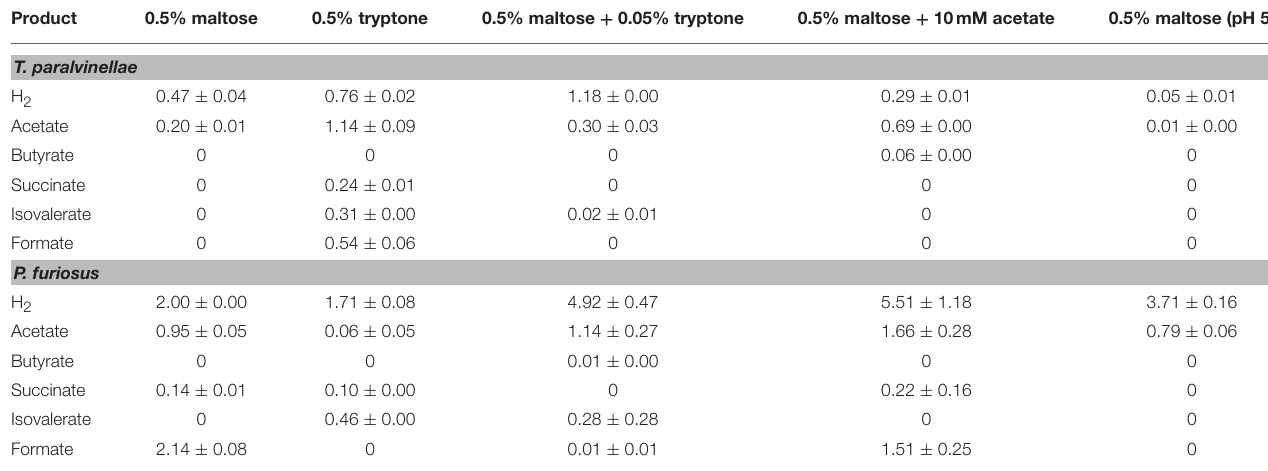
TABLE 2 | Mean product formation (mM, ± standard error) by T. paralvinellae and P. furiosus after 18h of incubation in the defined media relative to uninoculated controls.